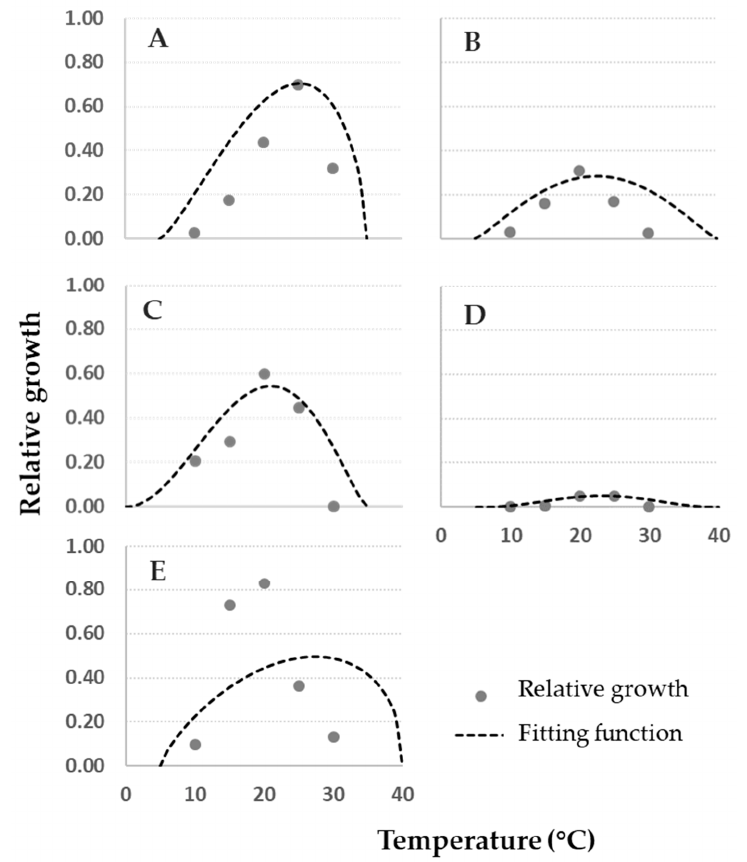
Figure 4. Data of fungal relative growth on cheese rind (grey dots) and the fitting functions based on relative growth data obtained on Czapeck Yeast Agar (dashed lines, [1]) for ( A ) Aspergillus versicolor , ( B ) Penicillium crustosum , ( C ) P. nordicum , ( D ) P. roqueforti, and ( E ) P. verrucosum at different temperature regimes (0–40 °C, step 5 °C).